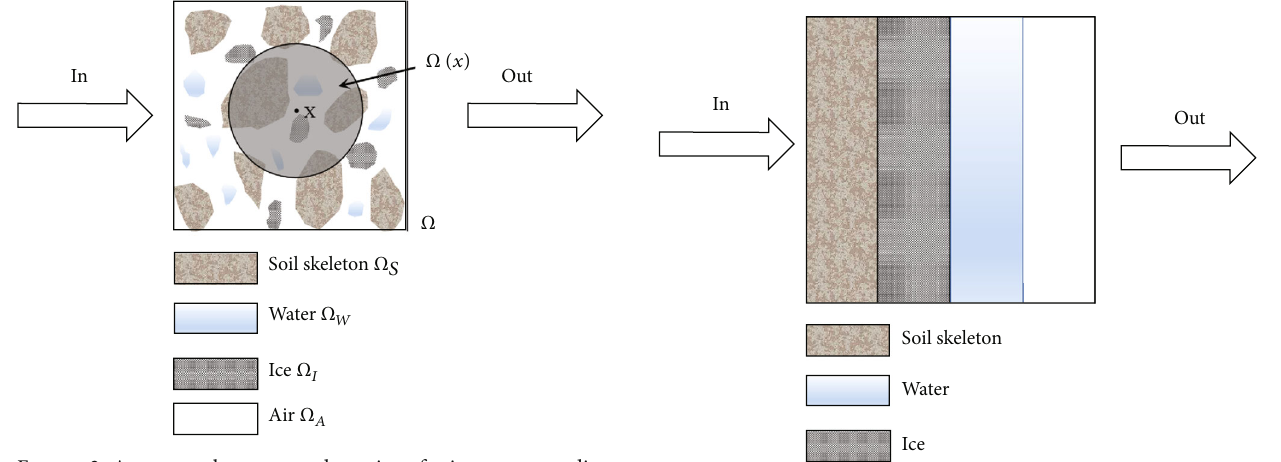
Figure 2: Average volume around a point of x in porous media.